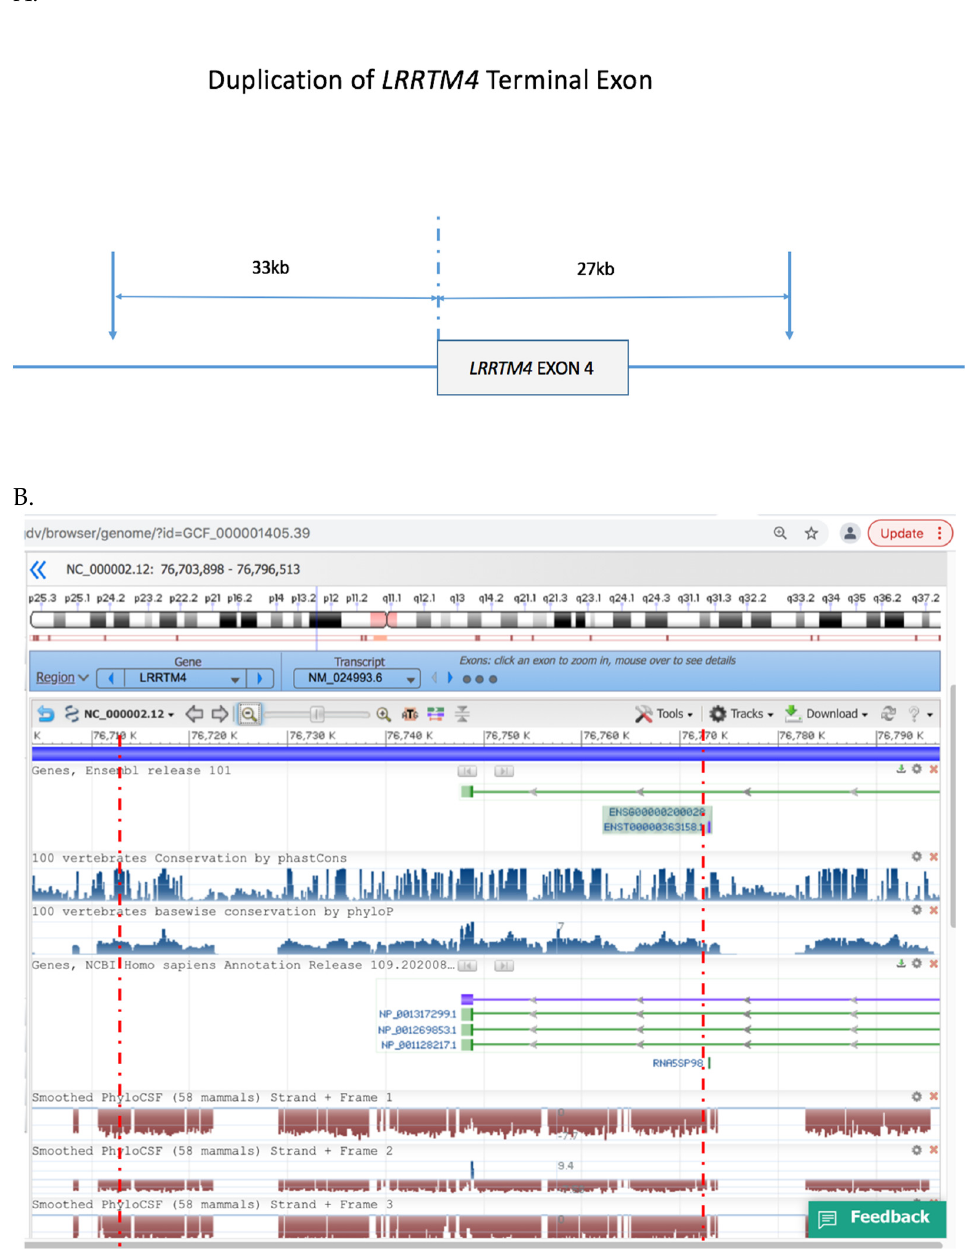
Figure 3. Duplicated region of LRRTM4 gene. ( A ). Schematic of LRRTM4 terminal exon duplica- tion, ( B ). NCBI profile of the genomic region duplicated in the proband and her affected mother, inclusive of the terminal exon of LRRTM4 inclusive of conserved noncoding regions. Red broken lines indicate the minimal critical region of the duplication. Reproduced with permission from NCBI Genome Data Viewer.